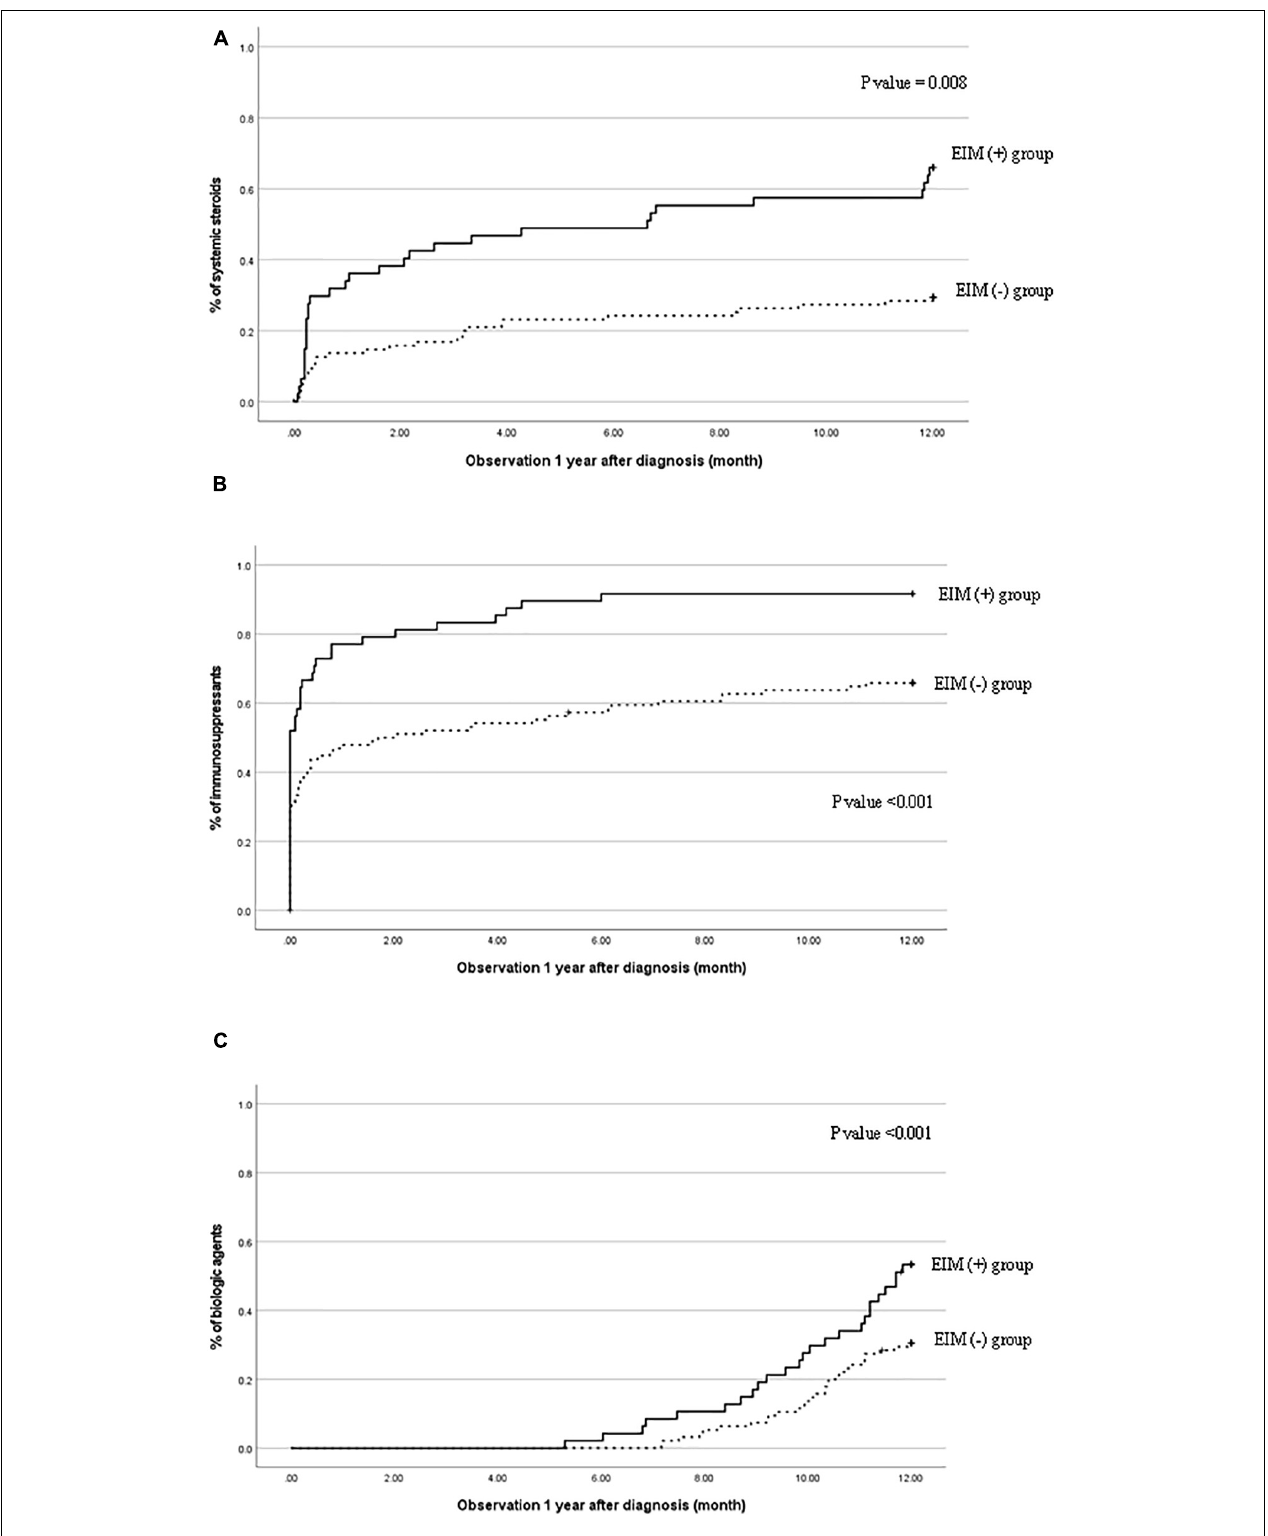
FIGURE 3 | Cumulative probability of (A) systemic steroids, (B) immunosuppressants, and (C) biological agents in patients with EIM (+) and patients with EIM ( − ). EIM, extraintestinal manifestation.